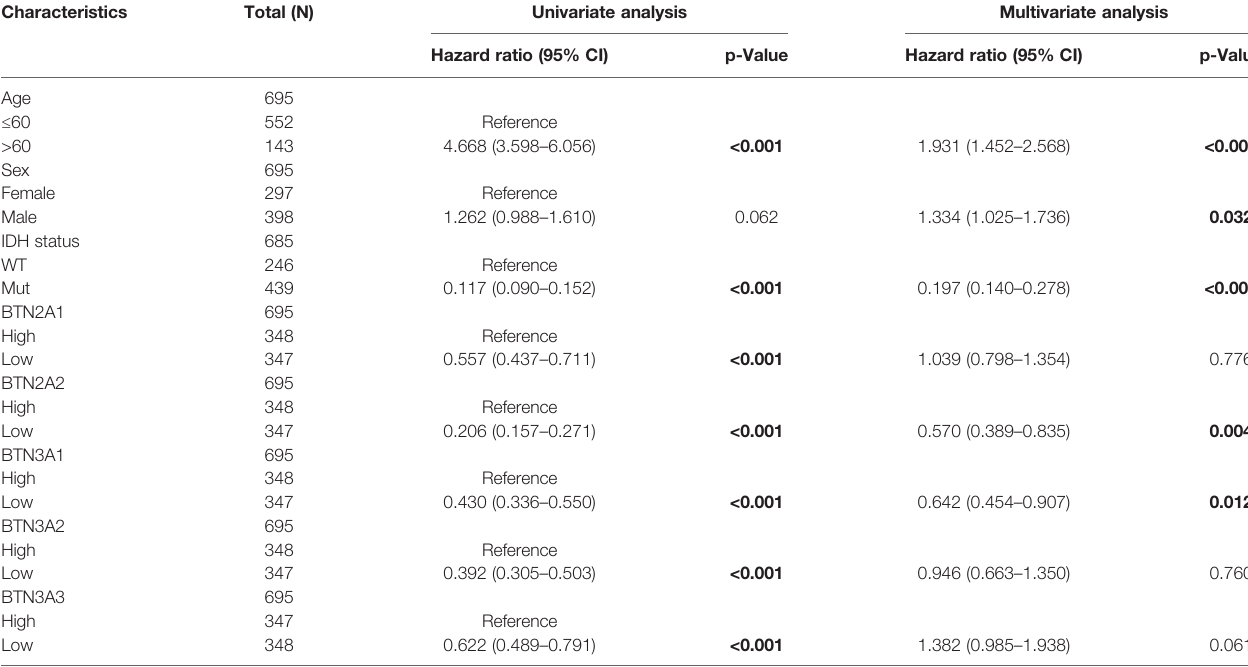
TABLE 2 | Univariate and multivariate analyses of the correlation of BTN2/3 subfamily mRNA expression with OS among GBMLGG patients. Characteristics